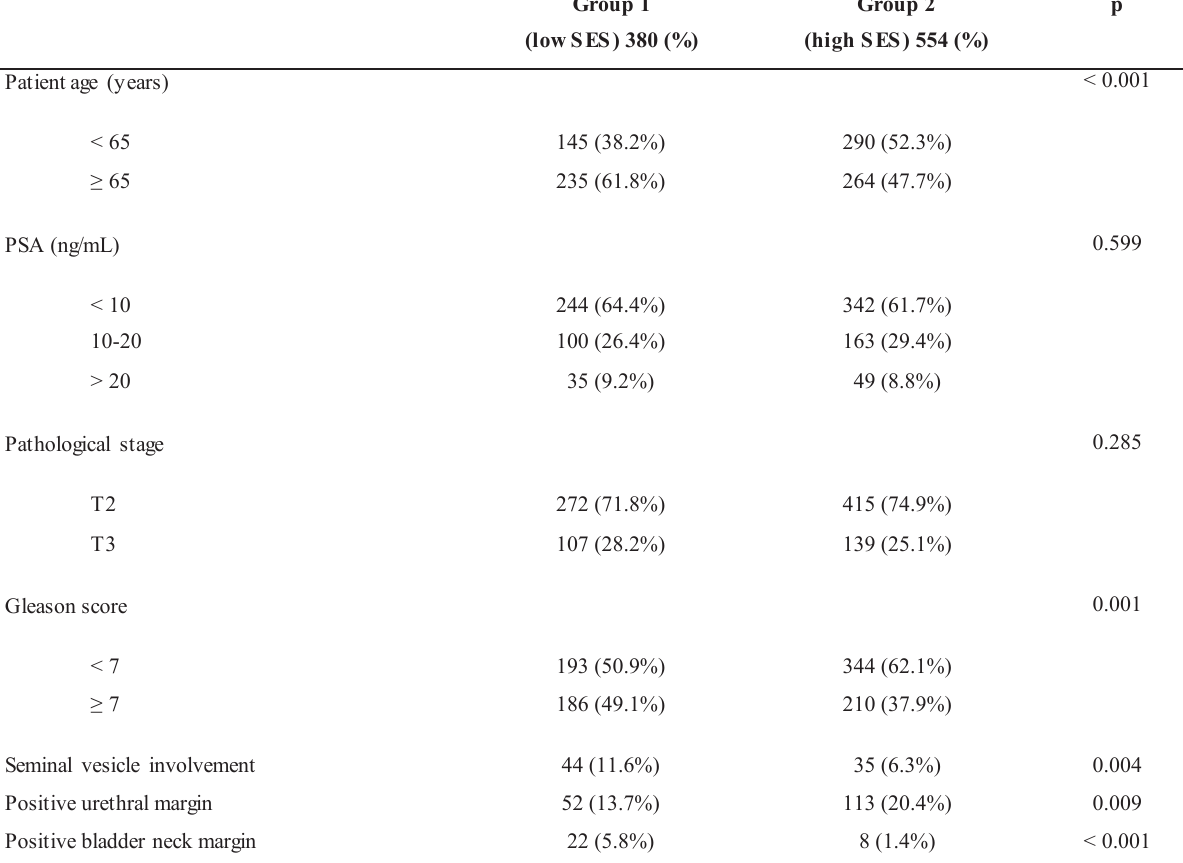
Table 1 - Clinical and pathological characteristics of patients. Table 1 – Clinical and pathological characteristics of